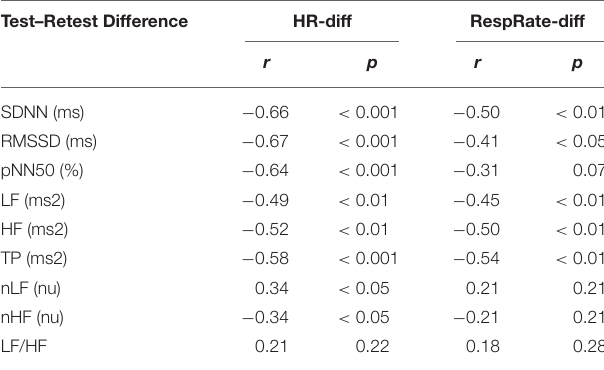
TABLE 1 | Correlations of Test–Retest differences in HRV parameters with Test–Retest differences in HR (HR-diff) and RespRate